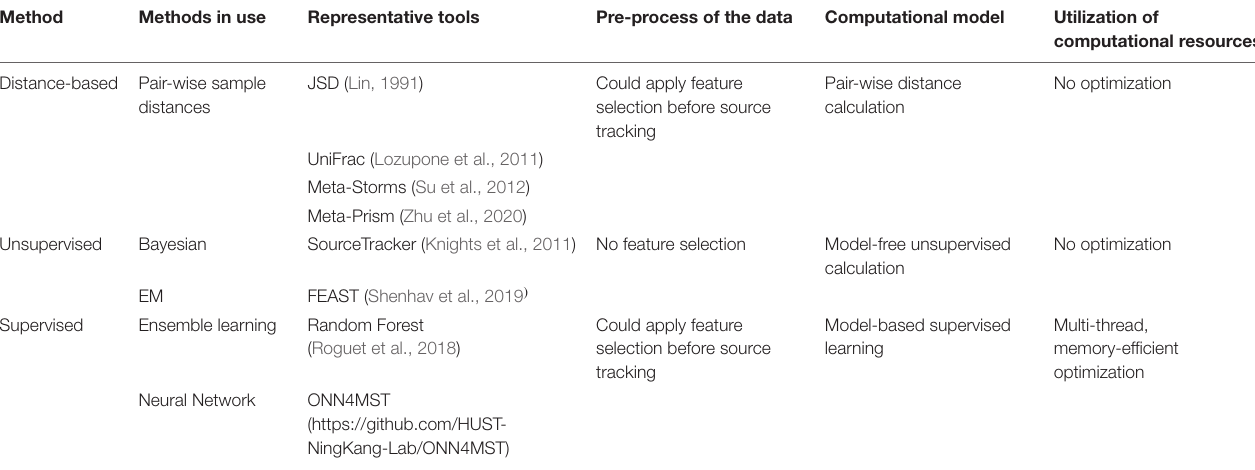
TABLE 1 | Computational resources and data utilization differences among current methods for microbiome sample comparison and